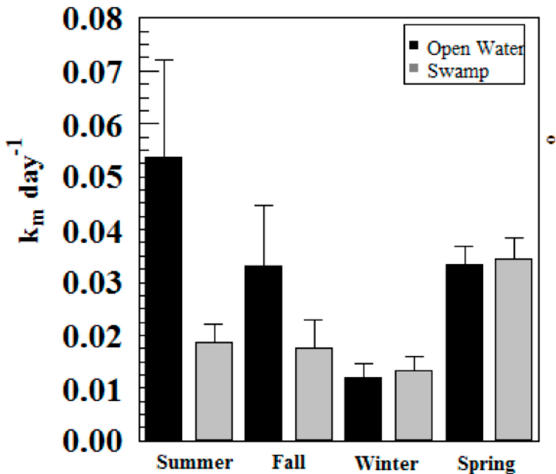
Figure 6. Hg methylation rates in Sky Lake by season ( n = 3 per sample).